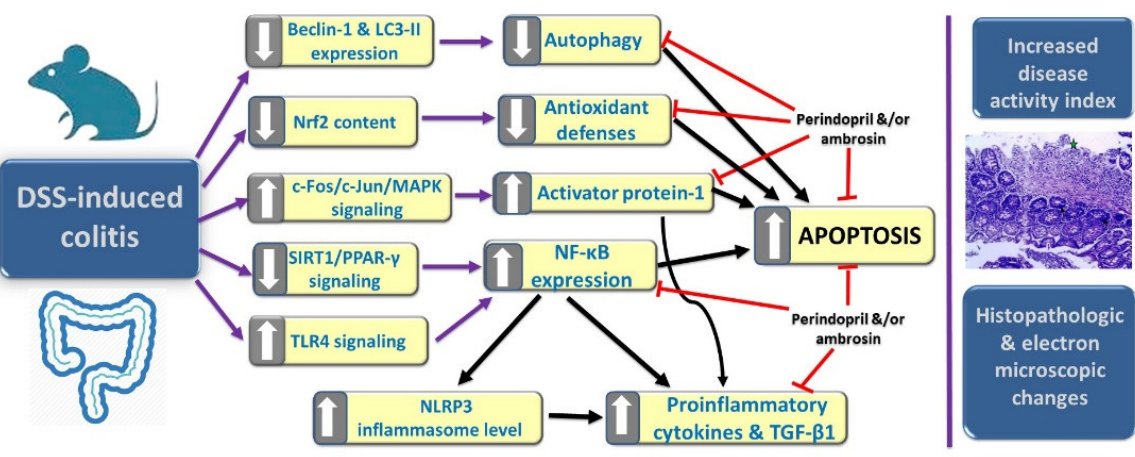
Figure 9. A summative diagram showing the mechanisms, by which perindopril and/or ambrosin may combat DSS-induced colitis.